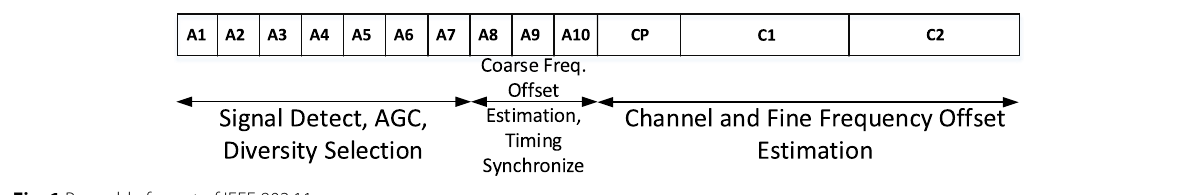
Fig. 1 Preamble format of IEEE 802.11a